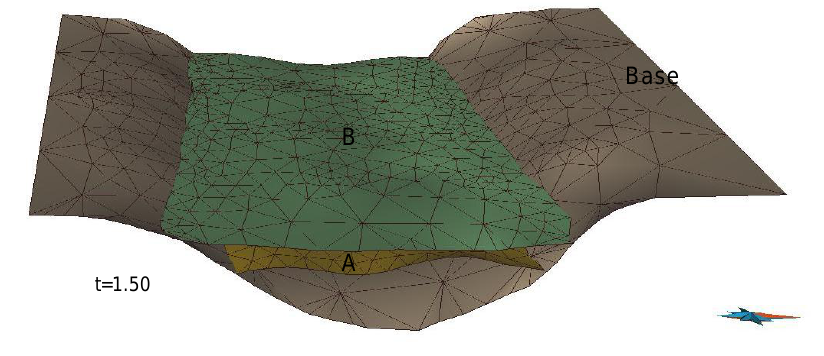
Figure 15. The geological structure of an area of interest at time t =